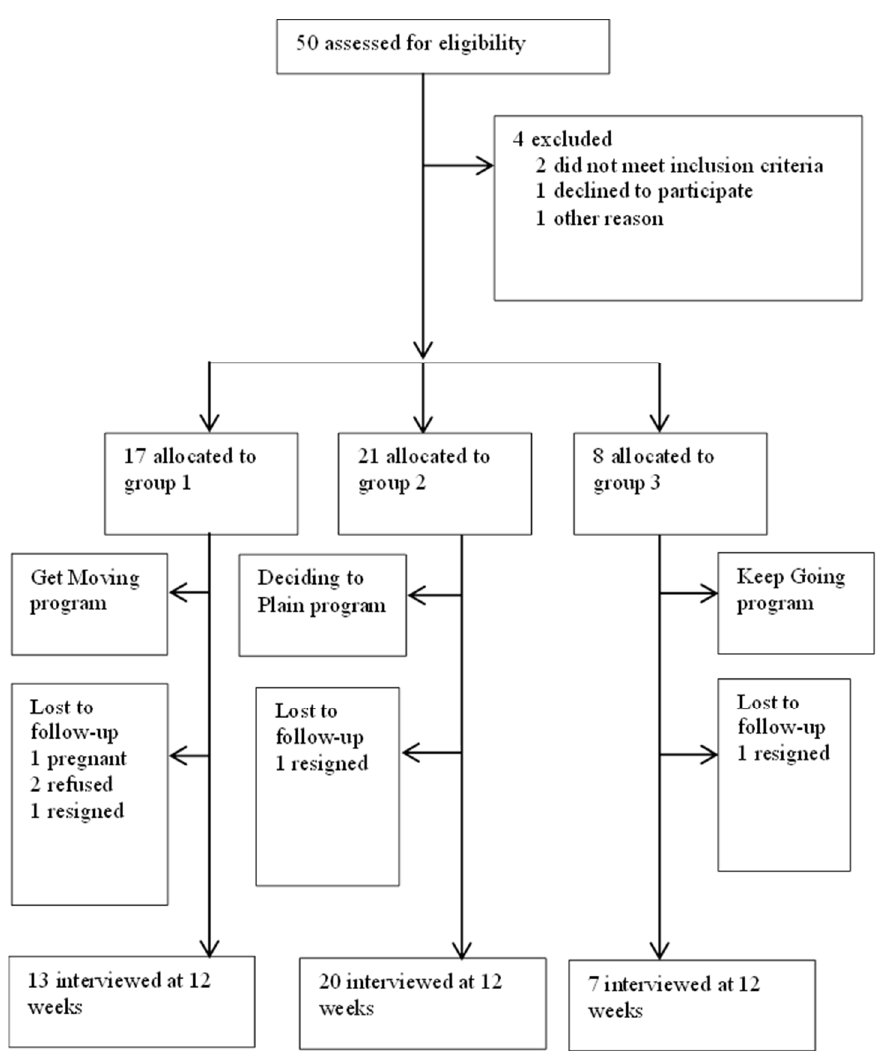
Figure 1. Flow diagram of the study.